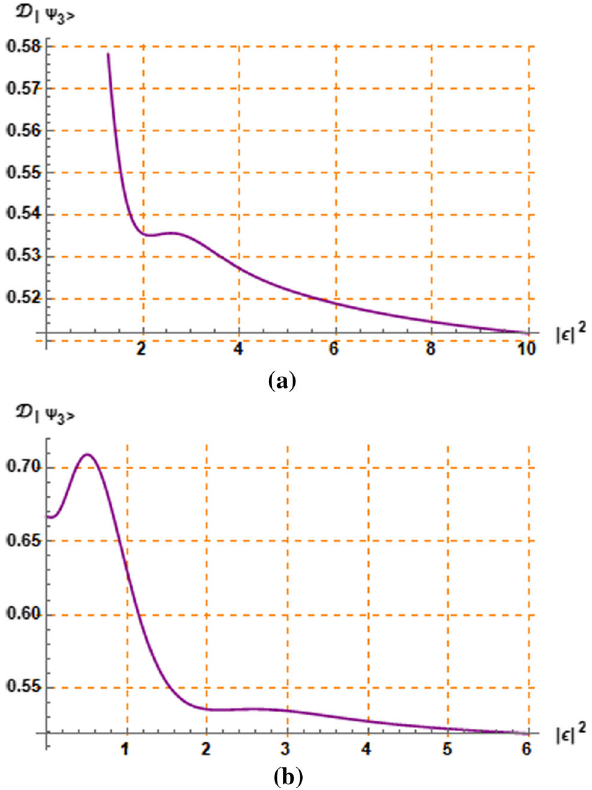
Fig. 10 a , b are plots for the dimensionless quantity in | Ψ 3 (cid:3) state of ETMC states, plotted as a function of coherent parameter | (cid:11) | . Note that the | Ψ 3 (cid:3) states are semiclassical states with D T (cid:10) 1 only when magnitude of the coherent parameter is not in the range 0 . 1 < | (cid:11) | 2 < 1, otherwise the states are very quantum. b is the reproduction of the portion of a corresponding to the range of values of | (cid:11) | 2 between 0 and